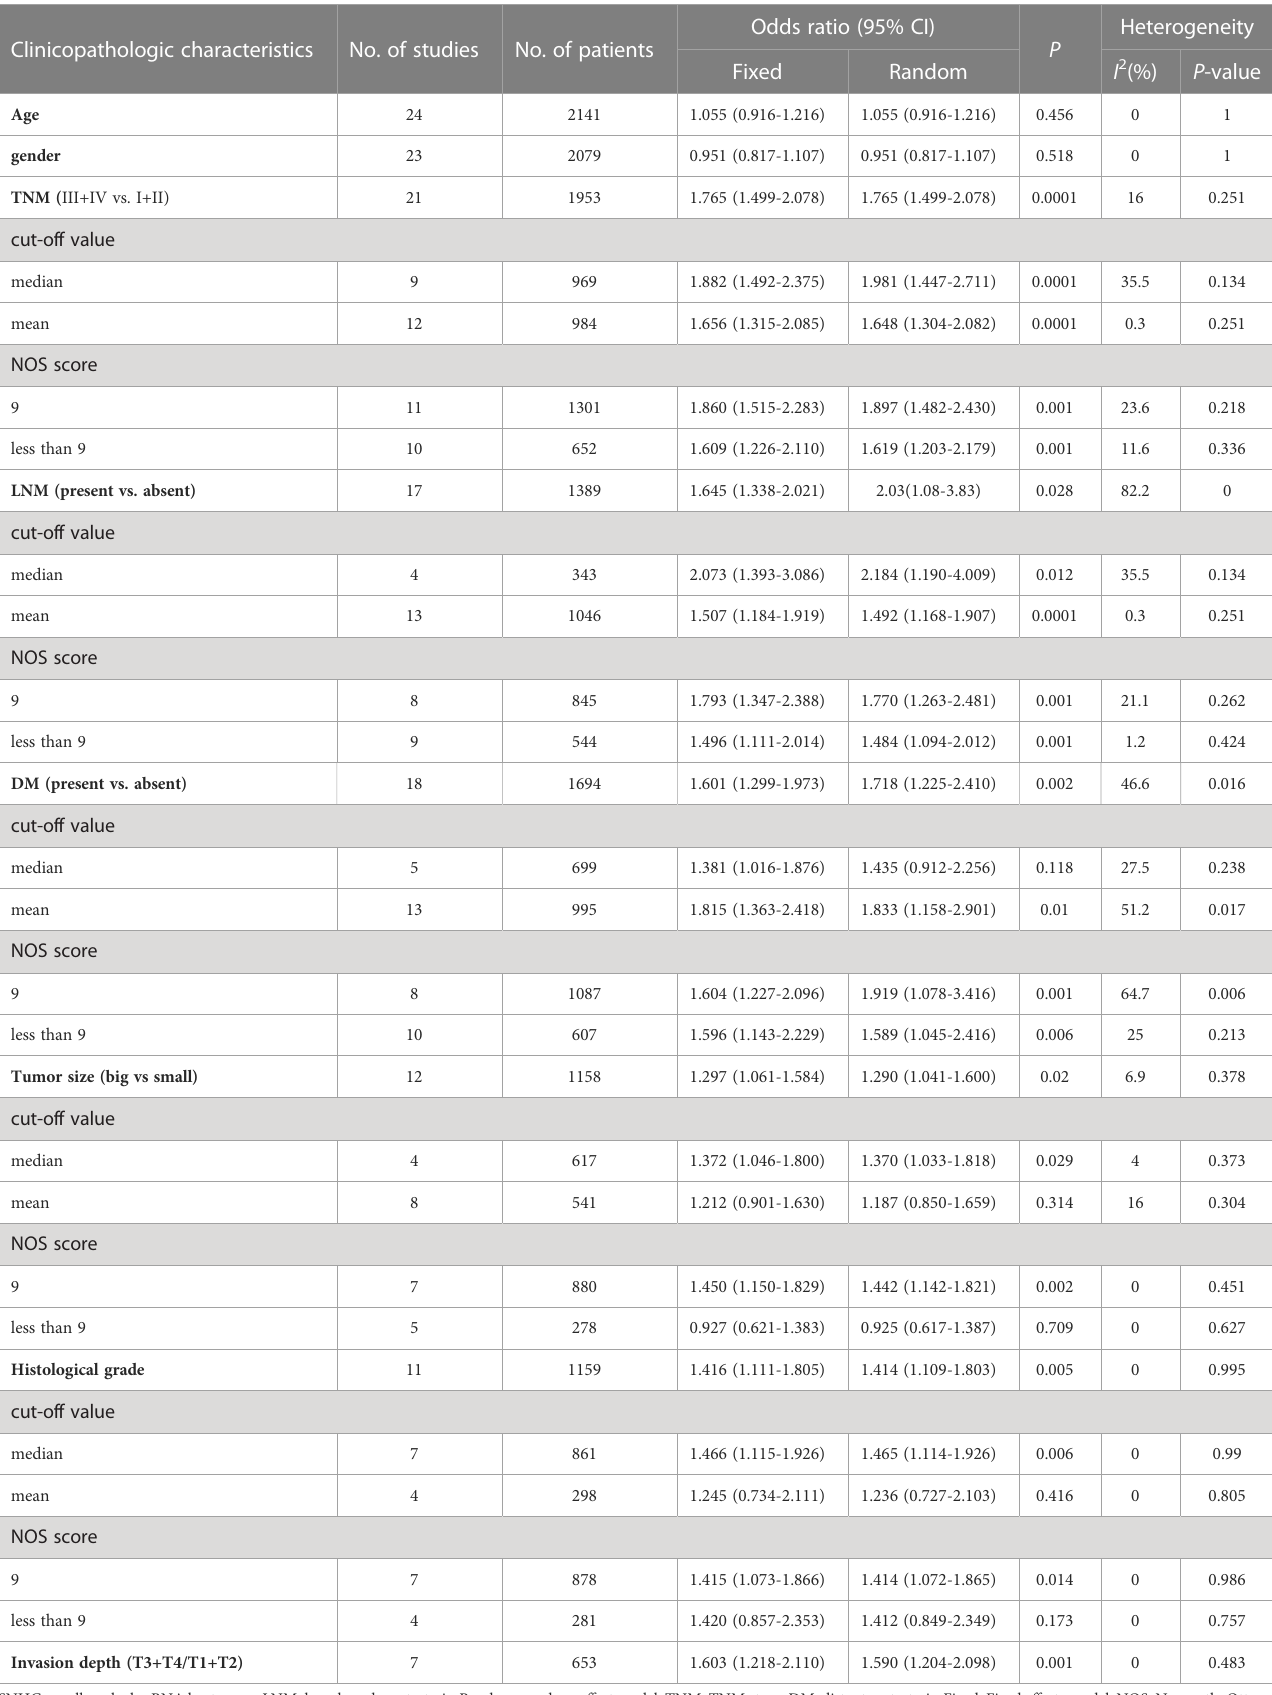
TABLE 4 Pool effects of clinicopathological characteristics in colorectal cancer patients with abnormal lncRNA SNHGs